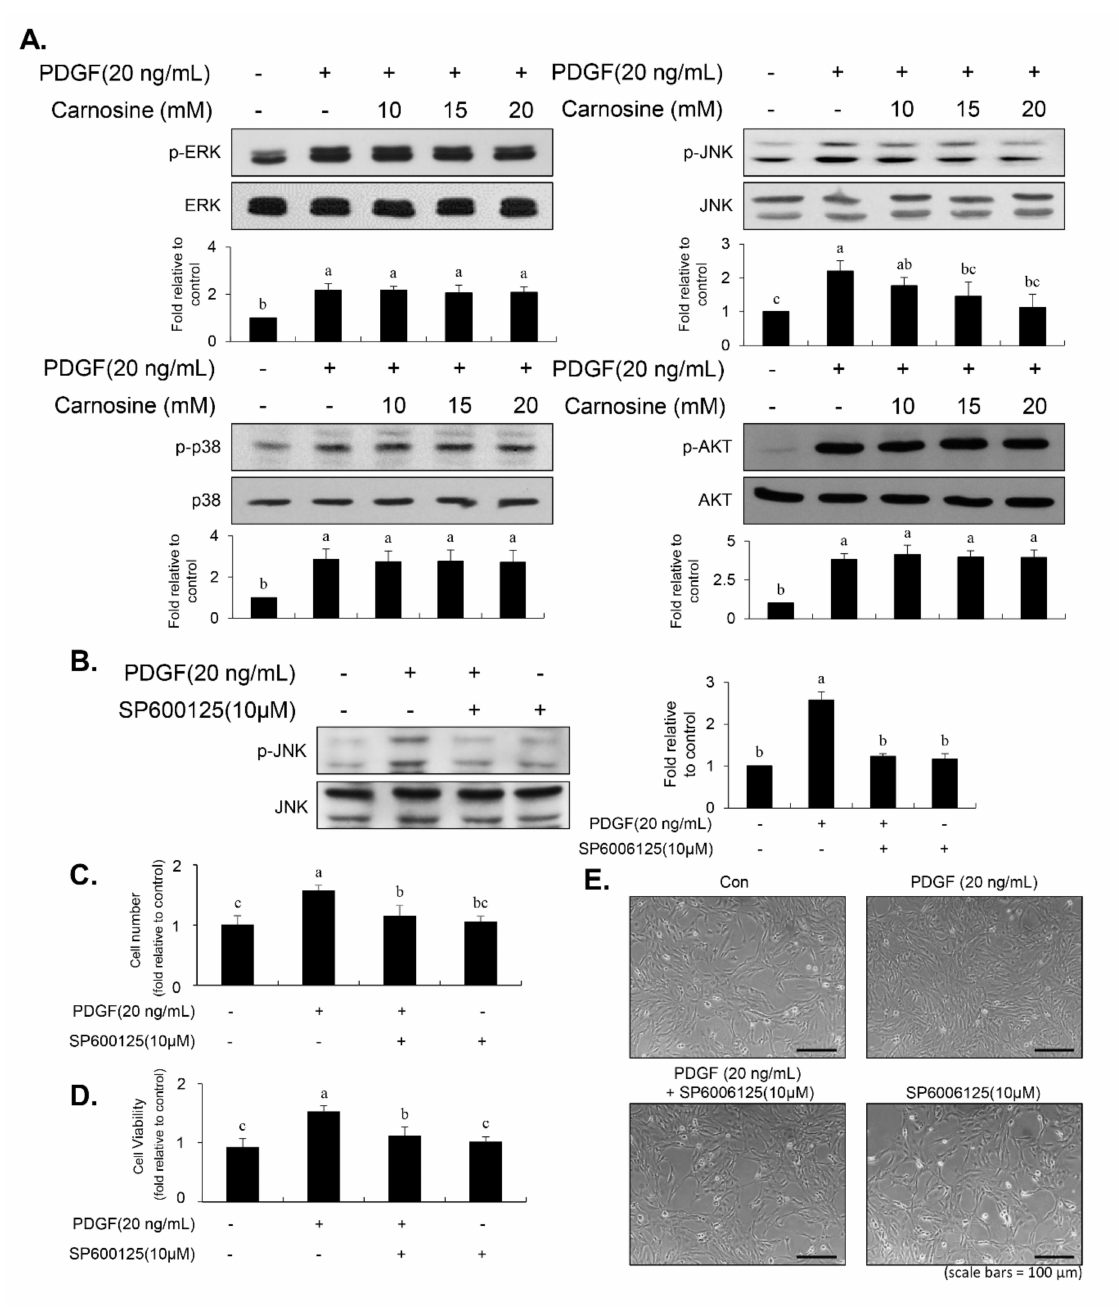
Figure 4. Carnosine suppressed JNK phosphorylation in PDGF-induced VSMCs. ( A ) VSMCs were pre-incubated with carnosine at the concentrations of 10, 15, and 20 mM for 45 min, followed by treatment with PDGF (20 ng / mL) for 10 min. Cell lysates were subjected to immunoblotting with specific antibodies against phospho-ERK1 / 2, ERK1 / 2, phospho-p38, p38, phospho-JNK, JNK, AKT, and phospho-AKT. The ratio of the phosphorylated form to the un-phosphorylated protein was estimated and indicated as a fold change compared with that of the control. ( B – E ) Cells were pre-treated with SP600125 (10 µ M) for 45 min, followed by PDGF treatment for 10 min or 24 h. Immunoblot ( B ), cell counting ( C ), MTT assay ( D ), and morphologic changes ( E ) were evaluated. Each value is expressed as the mean ± SD values of three independent experiments. The di ff erent letters indicate significant di ff erences between the groups ( p <